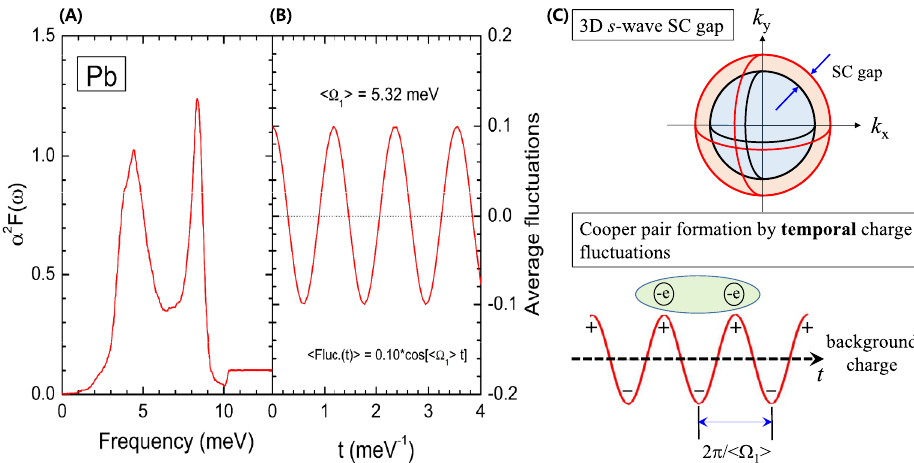
Figure 1. A conventional Bardeen–Cooper–Schrieffer (BCS) superconductor, Pb. ( A ) Electron–phonon 2 F (ω) spectral density function ( α ) of Pb. ( B ) Average charge fluctuations on top of the regular ion background charge. ( C ) Schematic diagrams for the s -wave superconducting (SC) gap and the Copper pair formation by the average charge fluctuations. Here + and − represent the positive and negative excess charge above the background charge,